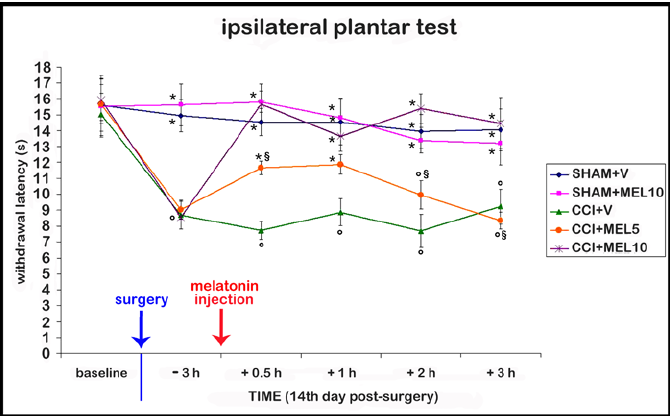
Figure 1. Behavioural test. Time course of the effect of different doses of melatonin (5 and 10 mg/kg) on thermal hyperalgesia evaluated as withdrawal latency to heat; this was measured by the plantar test on the right hind-paw and expressed in seconds (s). The administration of melatonin was performed as a single intraperitoneal injection at the 14th day after surgery, when the neuropathy was established. Sham-operated rats treated with 1% ethanol in saline (vehicle for melatonin) (SHAM + V); sham-operated rats treated with melatonin (10 mg/kg) (SHAM + MEL10); Chronic constriction injury (CCI) rats treated with 1% ethanol in saline (vehicle for melatonin) (CCI + V); CCI rats treated with melatonin (5 mg/kg) (CCI + MEL5); CCI rats treated with melatonin (10 mg/kg) (CCI + MEL10). Data represent means ± SEM, ° p < 0.05 vs SHAM + V, * p < 0.05 vs CCI + V, § p < 0.05 vs CCI + MEL10.